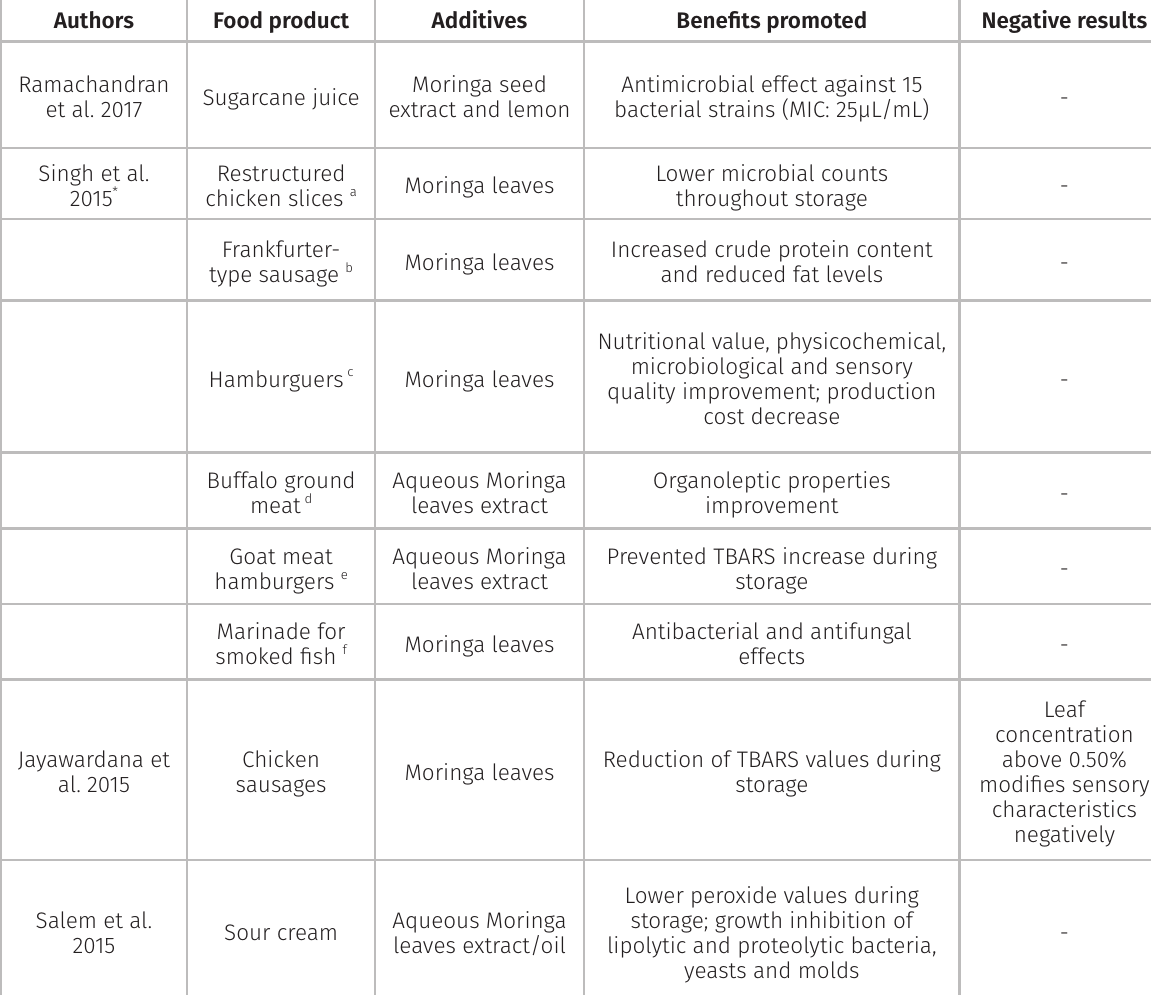
Table III. Summary of the benefits promoted by the incorporation of Moringa oleifera in different food products. Authors Food